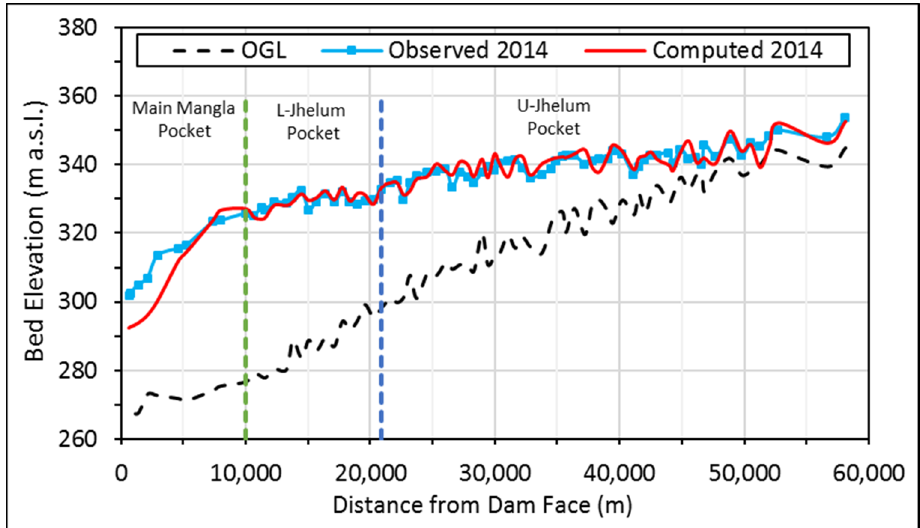
Figure 13. Validation of the numerical model for the year 2014. Table 2. Statistical analysis for sensitivity analysis for calibration and validation.